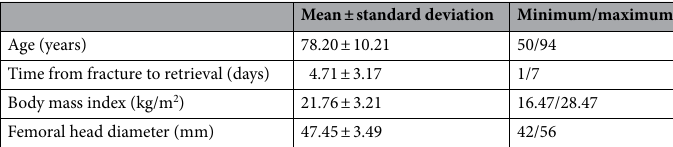
Table 1. Demographic data of the donor